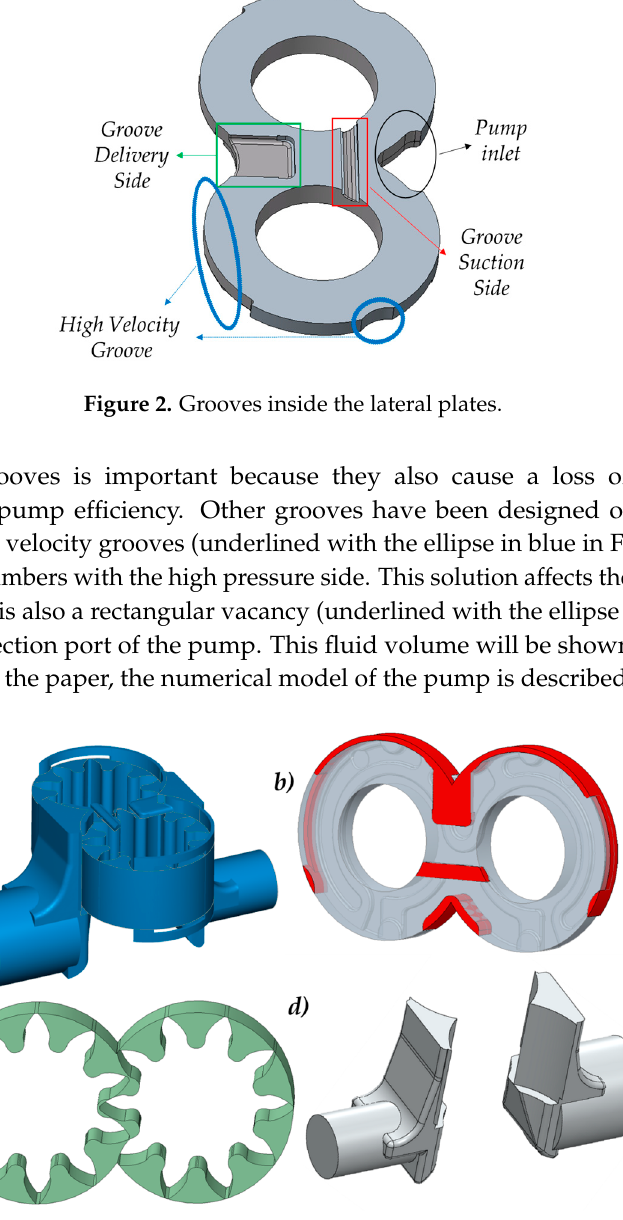
Figure 3. Extracted fluid volume of the external gear pump, ( a ) entire fluid volume, ( b ) fluid volume of the plate, ( c ) fluid volume in rotation, ( d ) fluid volume of the ports.